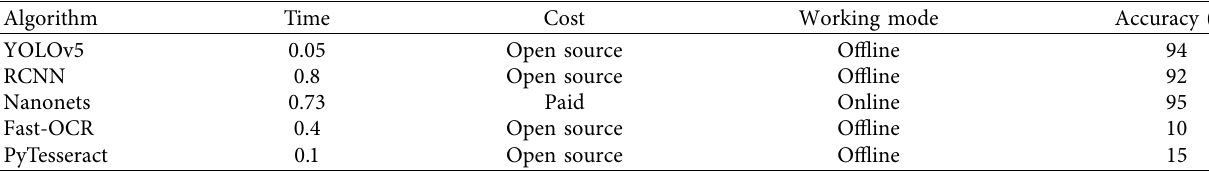
Table 2: Performance comparison of developed vs. existing algorithms.